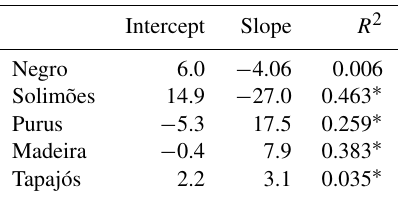
Table 2. Coefficients of the linear regression between evapotranspi- ration (ET) and MODIS enhanced vegetation index (EVI) for each of the five sub-basins. Intercept Slope R 2